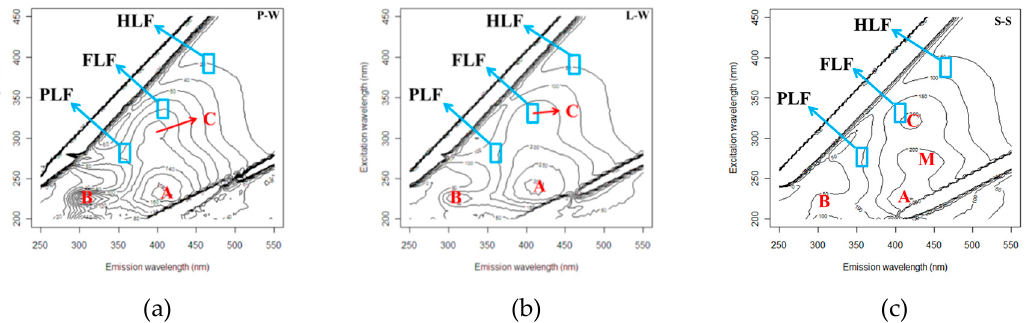
Figure 2. The excitation / emission matrix (EEM) plots of P-W, L-W and S-S, respectively. ( a ) P-W, ( b ) L-W, ( c ) S-S.